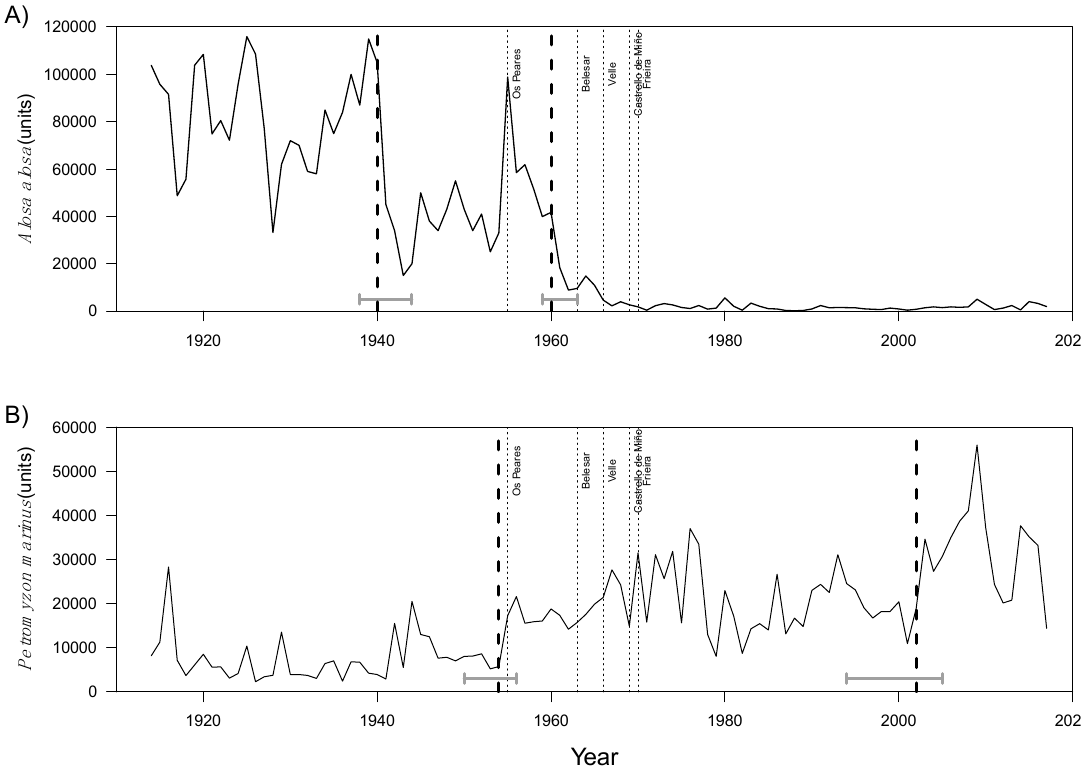
Figure 5. Capture data of Alosa alosa ( A ) and Petromyzon marinus ( B ) with the respective breakpoints and confidence intervals (2.5% and 97.5%) resulting from the Intervention Analysis. The dates when the main dams were constructed are also shown.